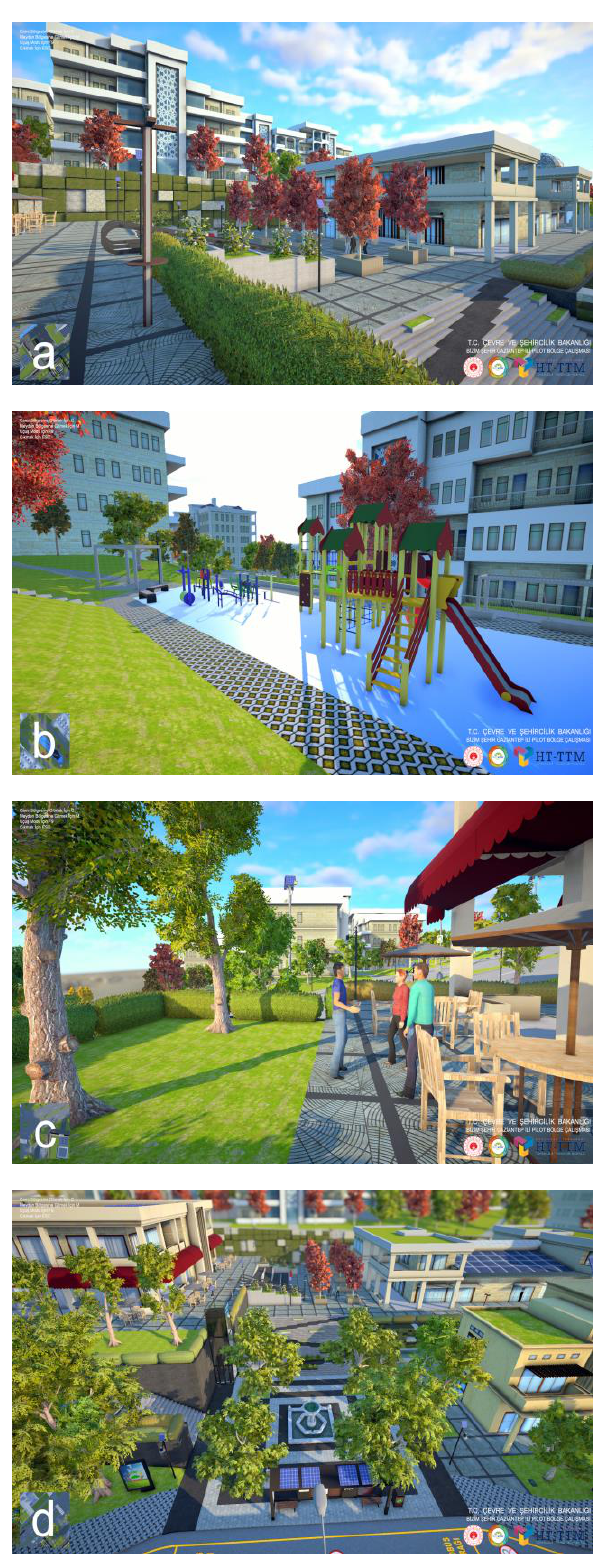
Figure 7. Views of city centre at street level (a), city furniture (b), animated citizens (c), and flying mode view